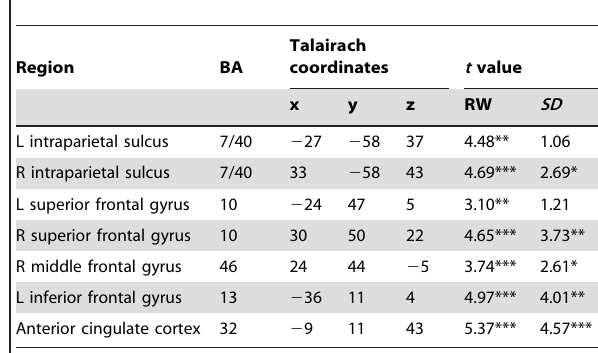
Table 2. Talairach coordinates of activation peaks in regions potentially mediating cognitive control identified by the conjunction of Attend House (AH) vs. baseline and Attend Face vs. baseline trials ( p , .001